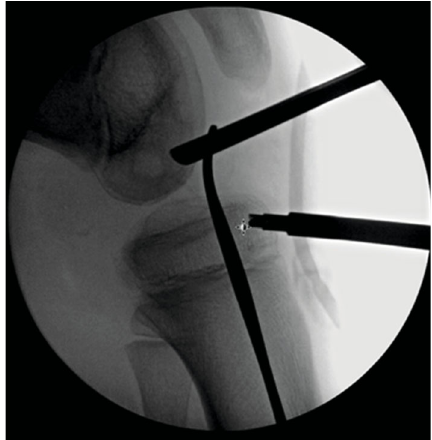
Figure 6: Fluoroscopic image to con fi rm epiphyseal